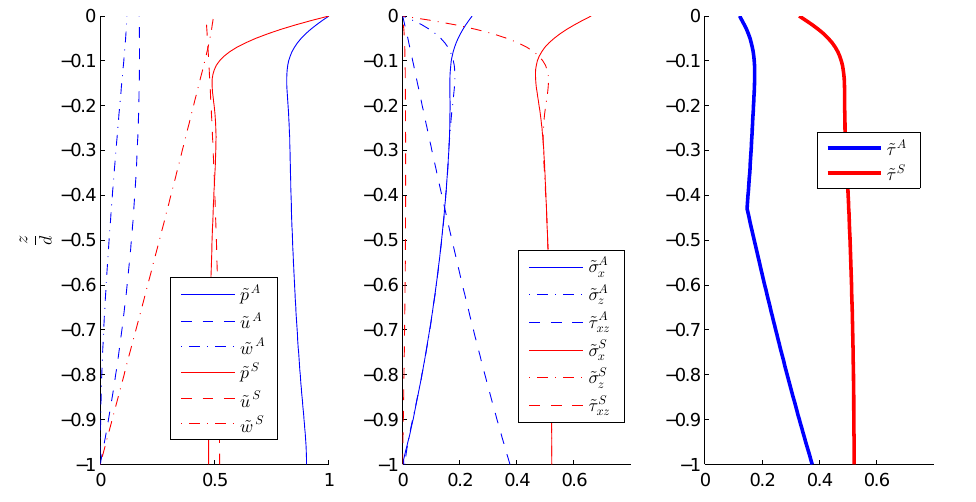
| | σ 0 | | σ 0 | τ xz | | p | | u | | w | z x , ˜ u = , ˜ w = , ˜ σ 0 x = , ˜ σ 0 z = , ˜ τ xz = and maximum shear stress amplitude for P 0 U 0 W 0 P 0 P 0 P 0